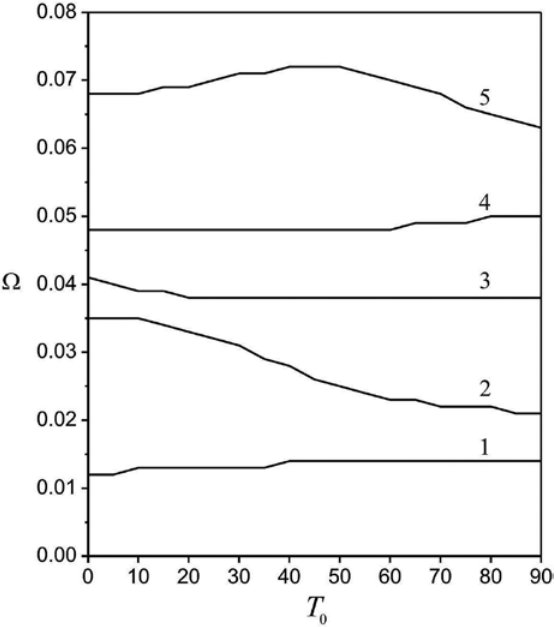
= 30 ° ) for the first ( T 0 1